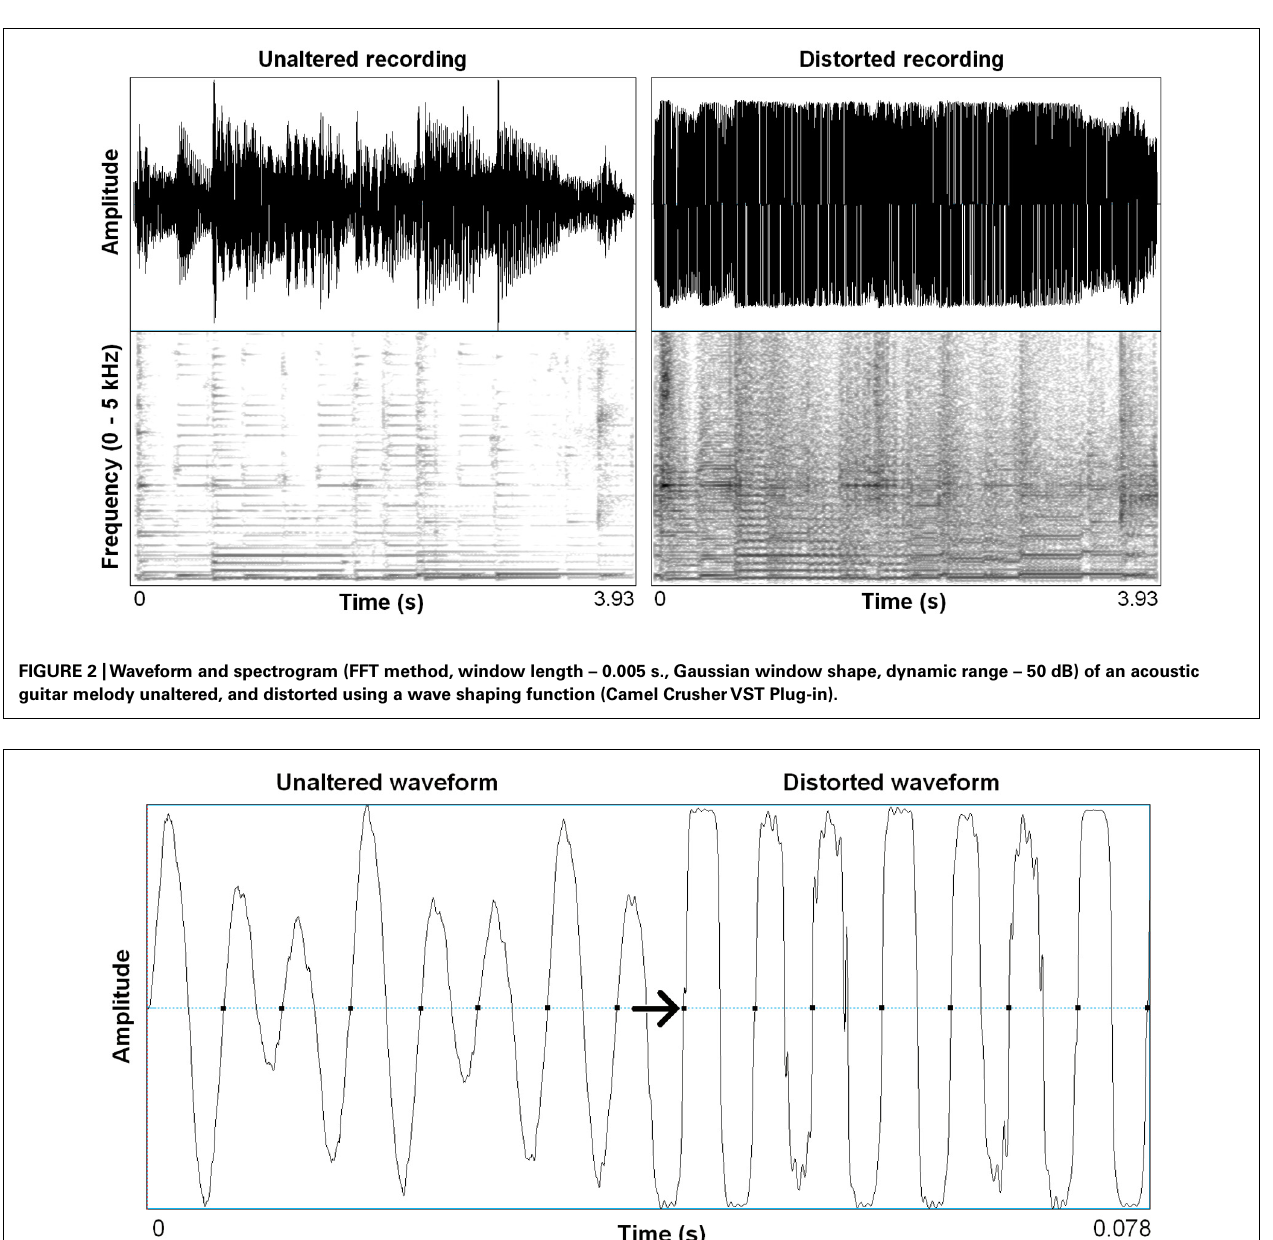
voices do not correspond to people’s judgments (Belin et al.,